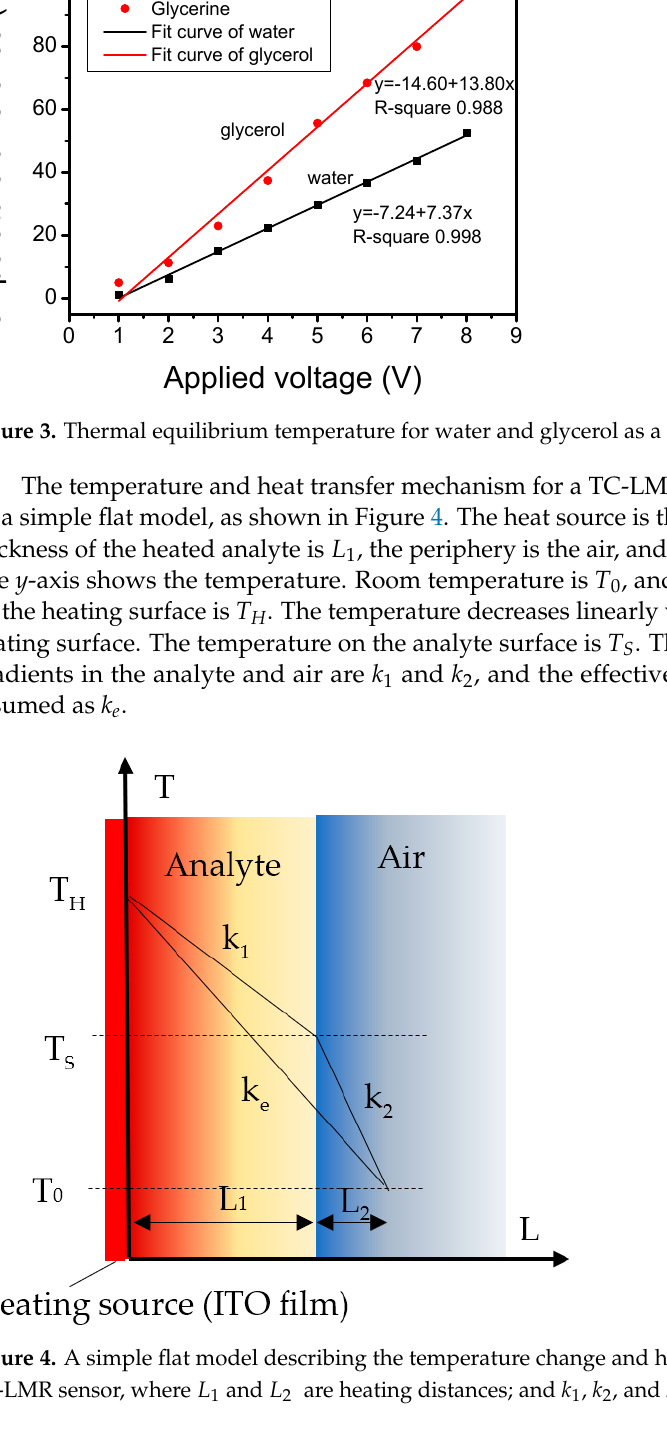
Figure 4. A simple flat model describing the temperature change and heat transfer mechanism for a TC-LMR sensor, where L 1 and L 2 are heating distances; and k 1 , k 2 , and k e are temperature gradi- ents.